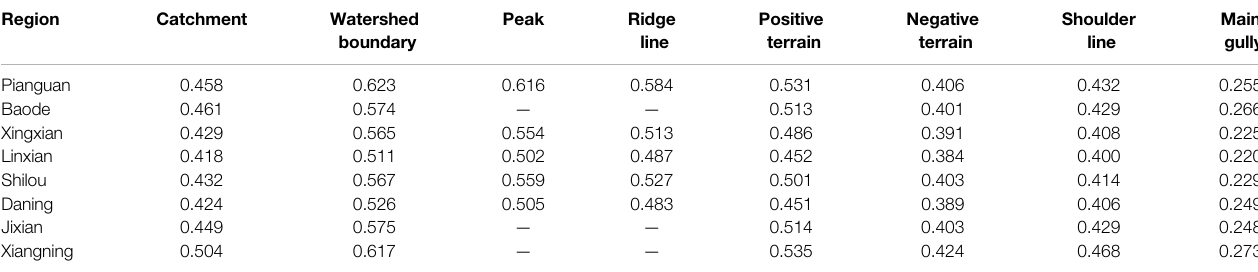
TABLE 3 | Hypsometric integral (HI) of landform features in each plot. Region